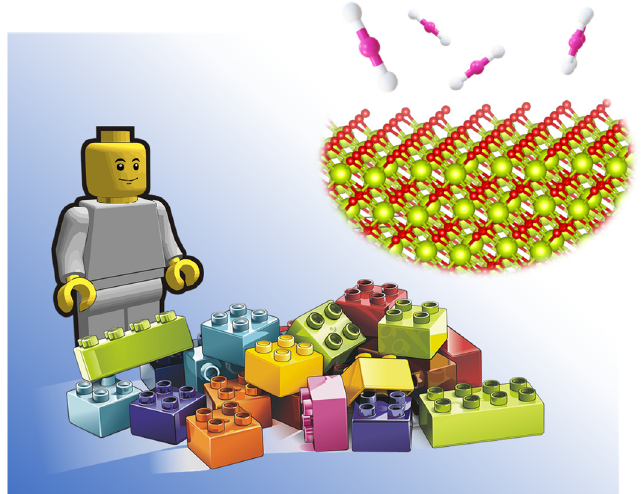
Figure 4. Rational design of efficient catalysts at atomic level: LEGO approach.